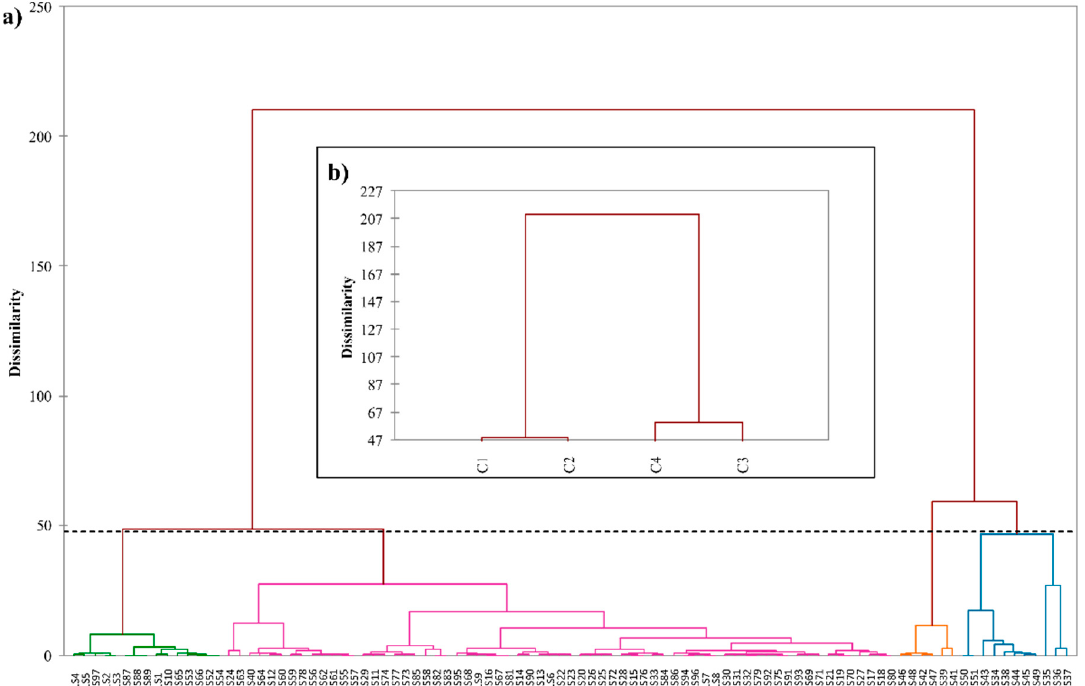
Figure 6. The clustering results through the dissimilarity impact between objects: ( a ) general results of HAC analysis; ( b ) simplified representation of results from HAC analysis.